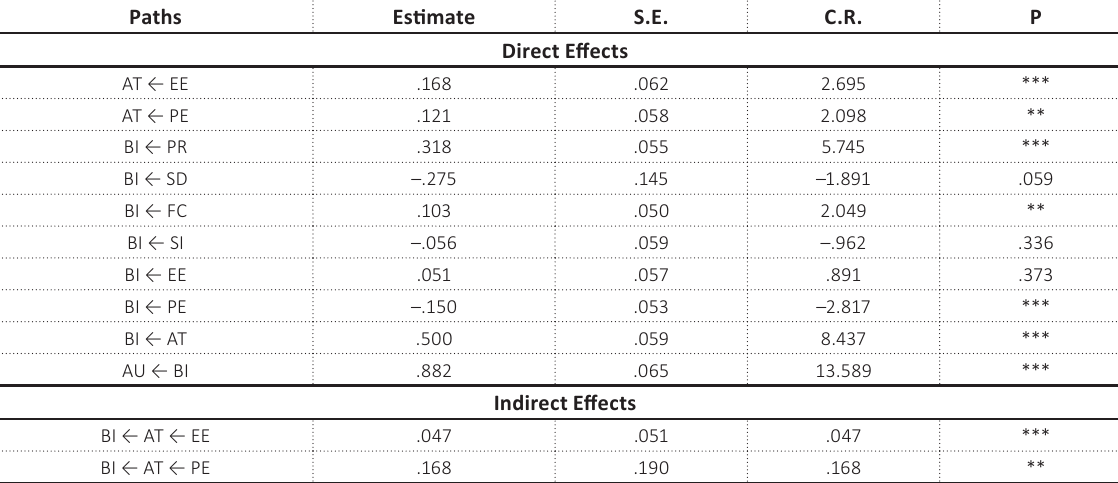
Table 3. Evaluation of study hypotheses Paths